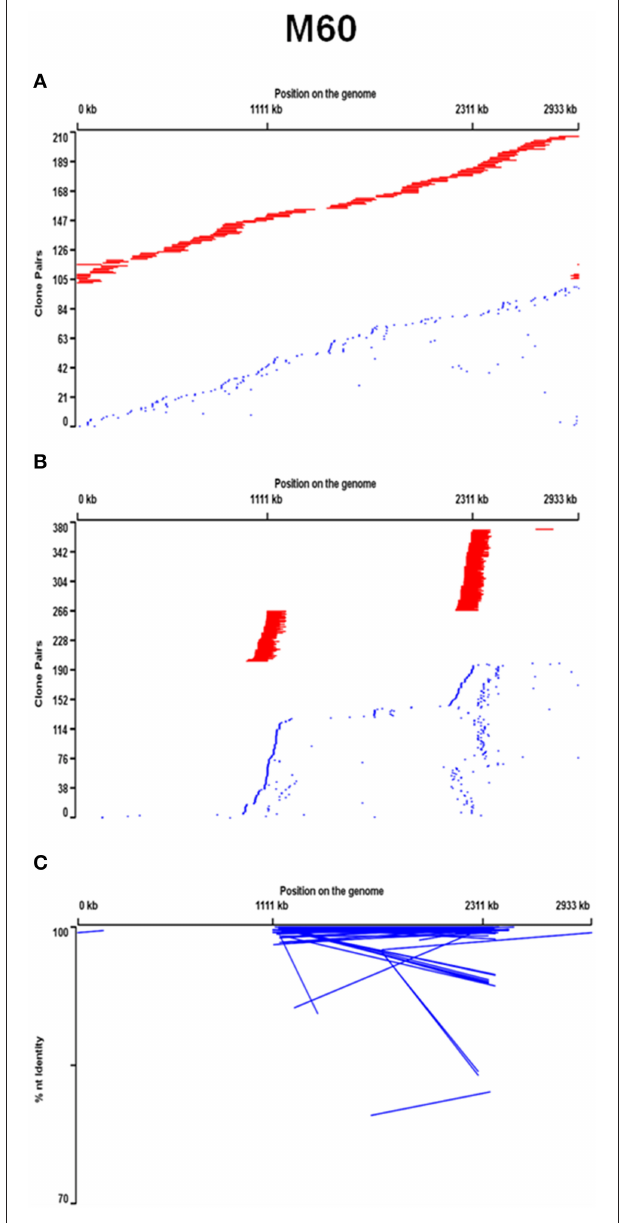
FIGURE 1 | Positional analysis relative to the Synechococcus strain A genome of jointly recruited syntenous (red line joins end sequences) and jointly recruited non-syntenous (blue) end sequences of 60 ◦ C BAC clones that are (A) recruited by this genome, and (B) contain an A-like Synechococcus 16S rRNA region, and (C) have anti-normal long end-sequence mate pairs. In (C) percent nucleotide identity of recruited sequences with genomic homologs is also plotted and lines connect